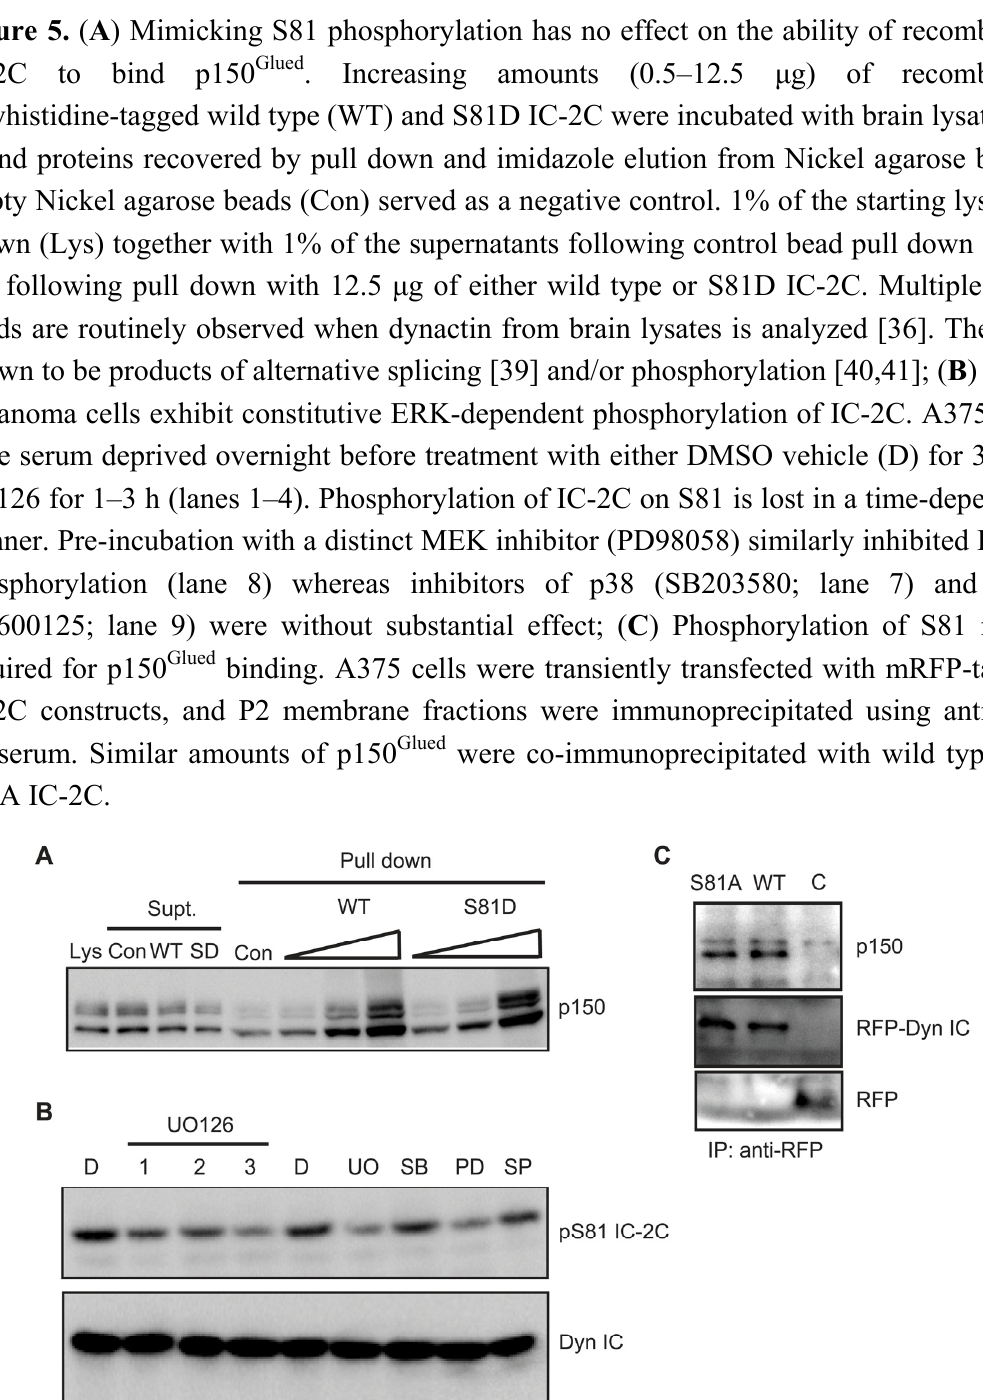
Figure 5. ( A ) Mimicking S81 phosphorylation has no effect on the ability of recombinant IC-2C to bind p150 Glued . Increasing amounts (0.5–12.5 μ g) of recombinant polyhistidine-tagged wild type (WT) and S81D IC-2C were incubated with brain lysate